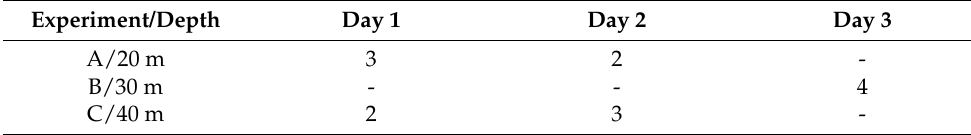
Table 1. The number of divers for each day and depth.